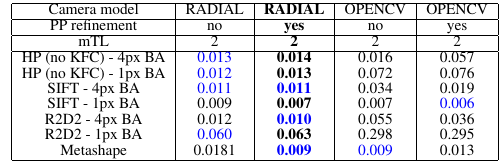
Table 5. RMSEs [m] for different camera setups of the Paestum Wall Oblique